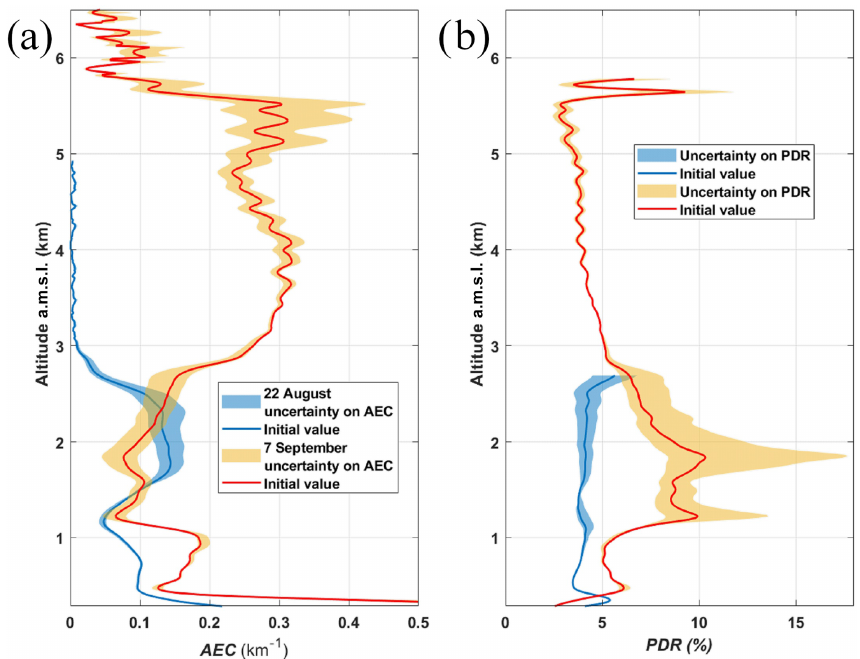
Figure A4. Vertical profiles of the (a) AEC and (b) PDR at 355nm on 22 August 2017 and 7 September 2017. The shaded areas give the uncertainty linked to the one on the LR of ± 25sr as considered for the CALIOP operational